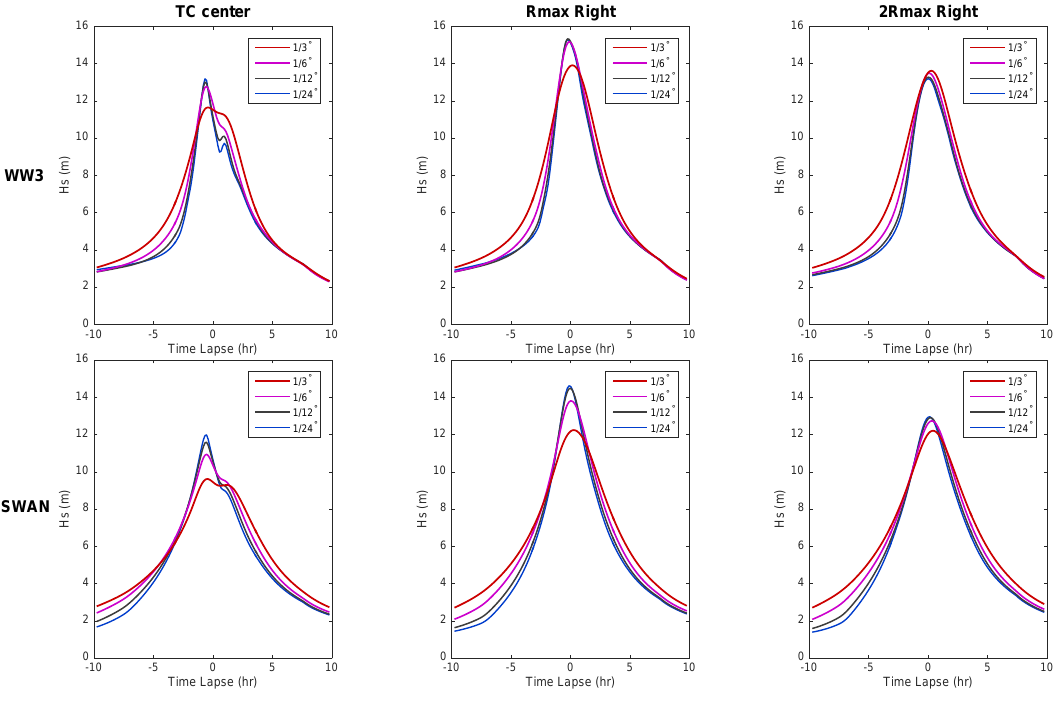
Figure 11. Time series of SWH at three virtual buoys (locations shown in Figures 5 and 6) under the small (RMW = 25 km) and fast moving ( U T = 9 m/s) storm: from WW3 ( top row ); and from SWAN ( bottom row ). SWH time series recorded at : storm center ( left column ); R max to the right of storm center ( center column ); and 2 R max to the right of storm center ( right column ). Red, magenta, black and blue lines denote results from the coarsest to the finest resolution.